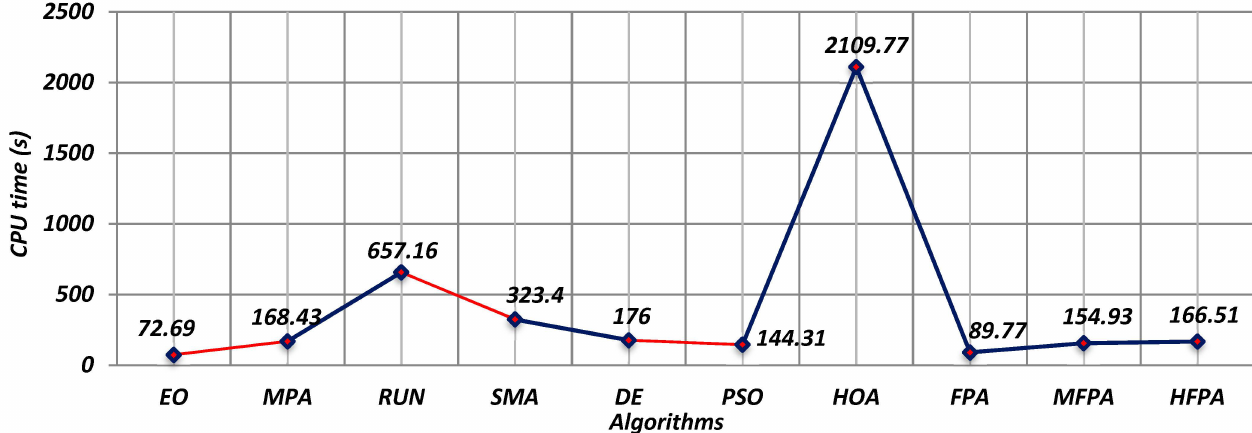
Figure 11. Comparison in terms of CPU time on